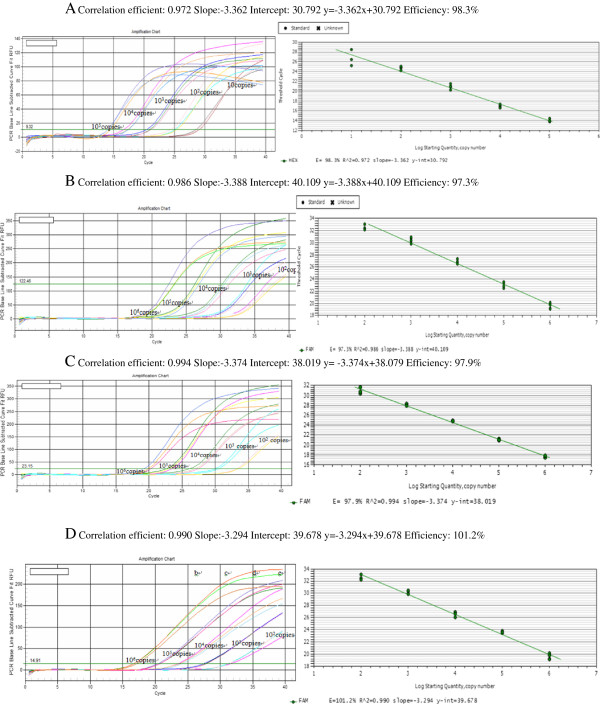
Standard curve for TaqMan real time RT-PCR amplification of standard ssRNA (viral transcripts). (A) Amplification plots showing the testing in triplicate of a 10-fold dilution series containing standard ssRNA of RBSDV at: 1x105(a); 1x104(b); 1x103 (c); 1x102(d); 1x101(e) template copies per reaction. (B) Amplification plots showing the testing in triplicate of a 10-fold dilution series containing standard ssRNA of SRBSDV at: 1x106(a); 1x105(b); 1x104 (c); 1x103(d); 1x102(e) template copies per reaction. (C) Amplification plots showing the testing in triplicate of a 10-fold dilution series containing standard ssRNA of eEF-1a at: 1x106(a); 1x105(b); 1x104 (c); 1x103(d); 1x102(e) template copies per reaction. (D) Amplification plots showing the testing in triplicate of a 10-fold dilution series containing standard ssRNA of UBQ5 at: 1x106(a); 1x105(b); 1x104 (c); 1x103(d); 1x102(e) template copies per reaction.